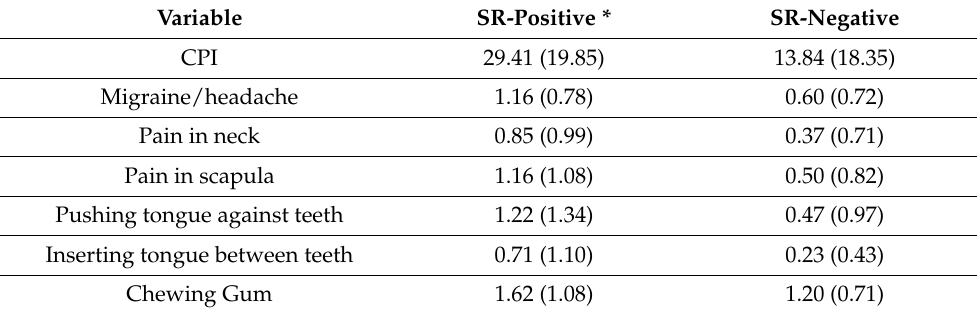
Table 2. Significant differences between the SR groups (2-way